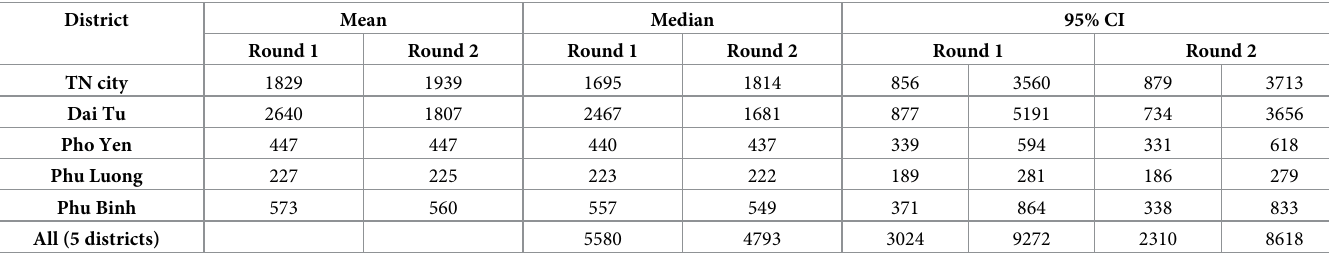
Table 2. Successive sampling PSE (SS-PSE) in survey districts.